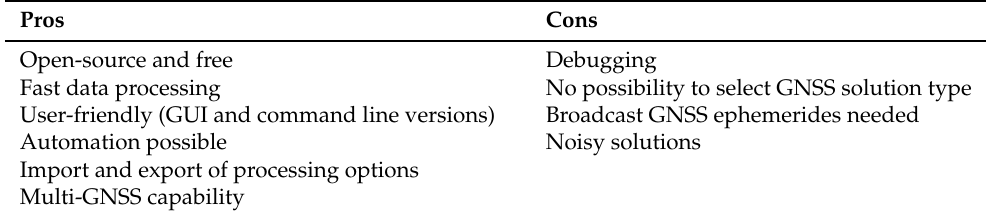
Table 2. Applicability of RTKLIB for SWE